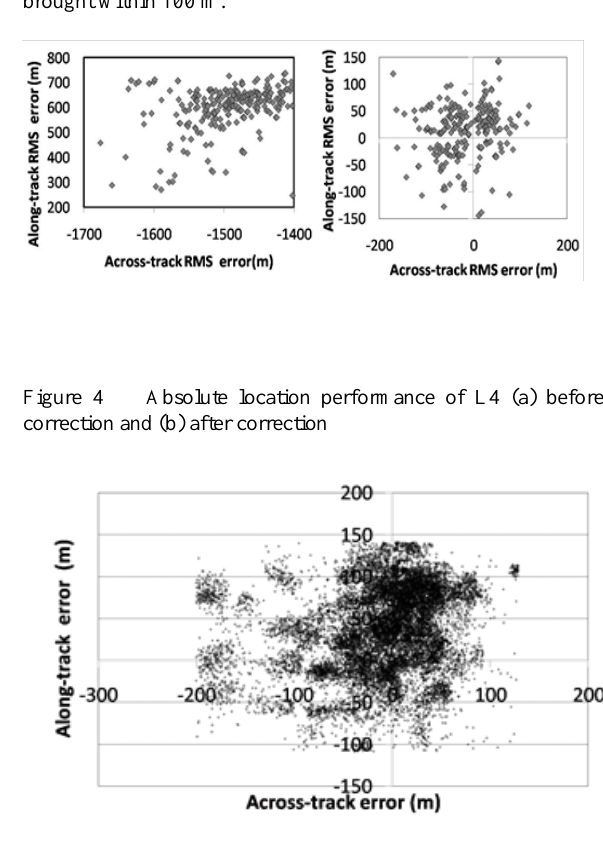
Figure 5 Absolute location performance of L4 (Band3) with system knowledge after alignment angle correction (16244 Points from different datasets)